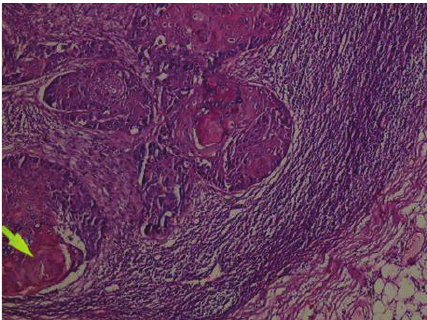
Figure 5: In the lower-right part, a well-preserved lymph node with its peripheral adipose tissue is seen but in the upper-left and lower- left (arrow shows central keratinization) parts of the same lymph node there are squamous cell cancer foci (neoplastic cells with large nuclei, wide eosinophilic cytoplasmic